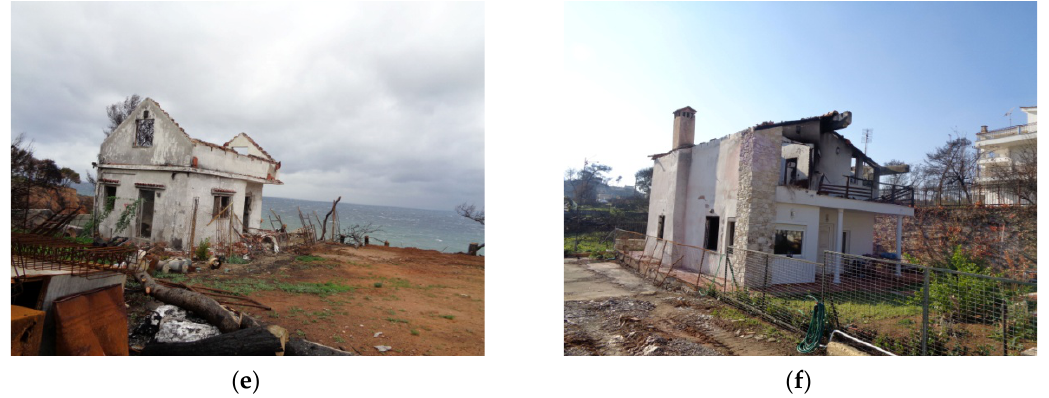
Figure 10. Pictures of buildings characterized as repairable ( a – c ), non-repairable ( d , e ), or with a nonrepairable upper floor ( f ).